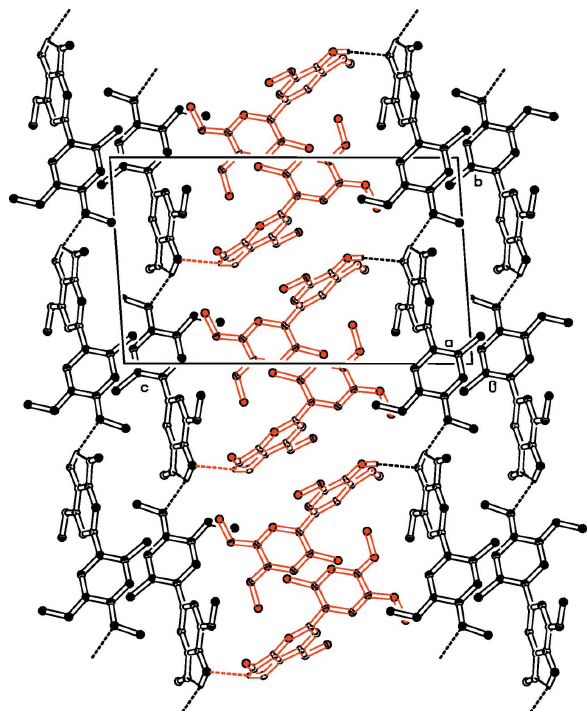
Figure 2 A partial packing diagram viewed along [100] with A molecules in black and B molecules in red. Hydrogen bonds are shown as dashed lines.